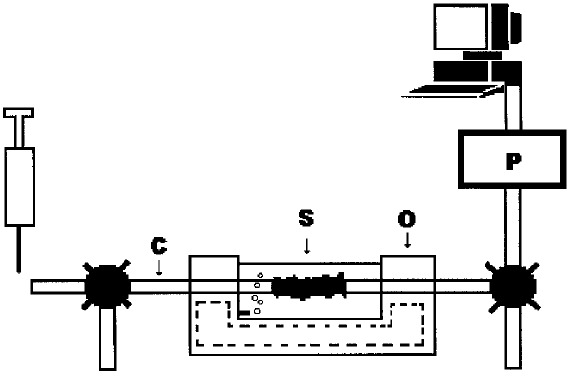
FIG. 1. Schematic presentation of the in vitro model. The intestinal segment (S) is cannulated with stainless-steel cannulas (C) and mounted in a double-walled organ bath (O) that contains carbogenated standard Krebs buffer at 37°C. The intestinal lumen is filled with standard Krebs buffer containing marker molecules via a syringe. The distal cannula is connected to a low pressure sensor (P). Con- tractility is recorded as pressure difference compared to a reference port and registered by Multiple Channel Registra- tion